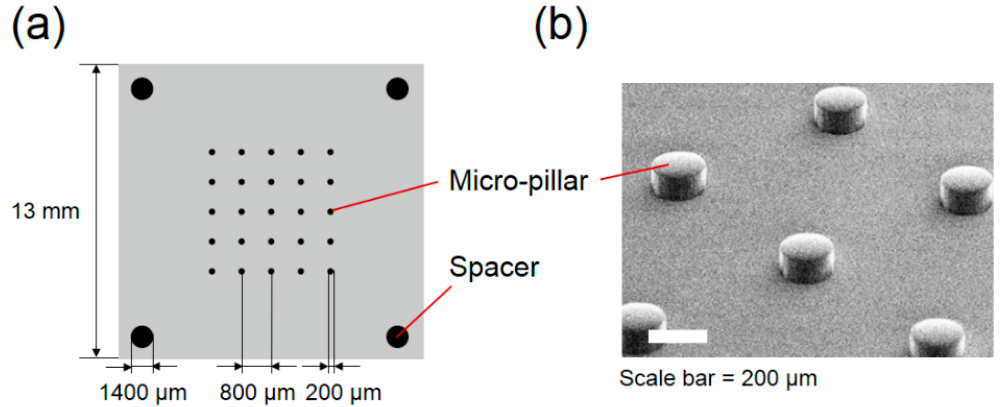
Figure 2. ( a ) Arrangement of the micro-pillars on a substrate. ( b ) SEM image of the micro-pillars.